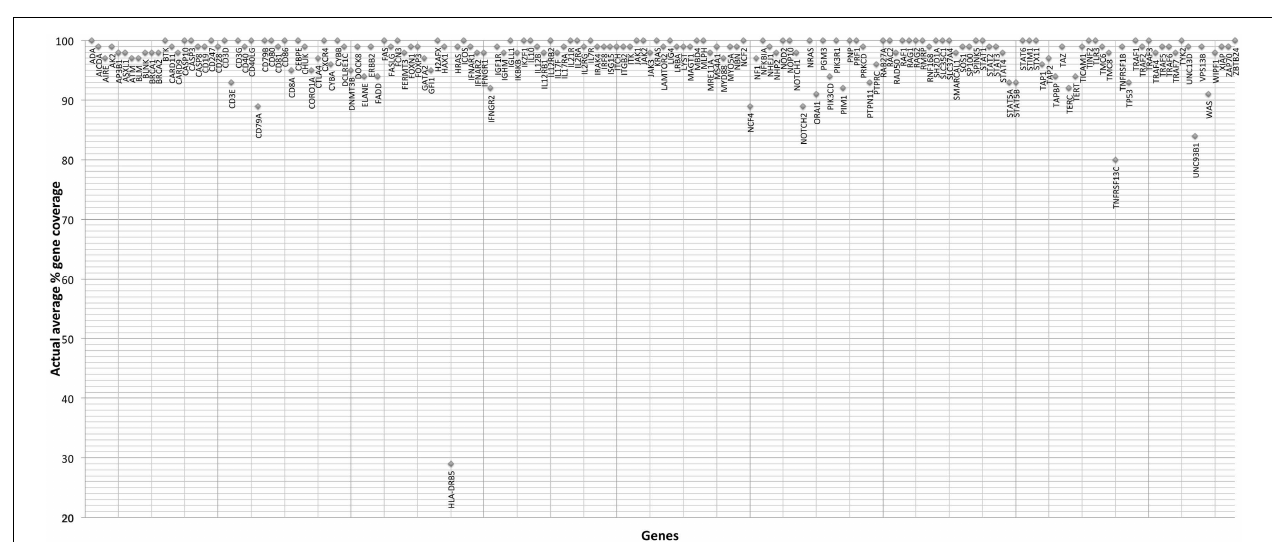
FIGURE 1 | Gene-by-gene coverage analysis for 33 samples run using the default HaloPlex probe hybridization protocol and ion torrent PGM .